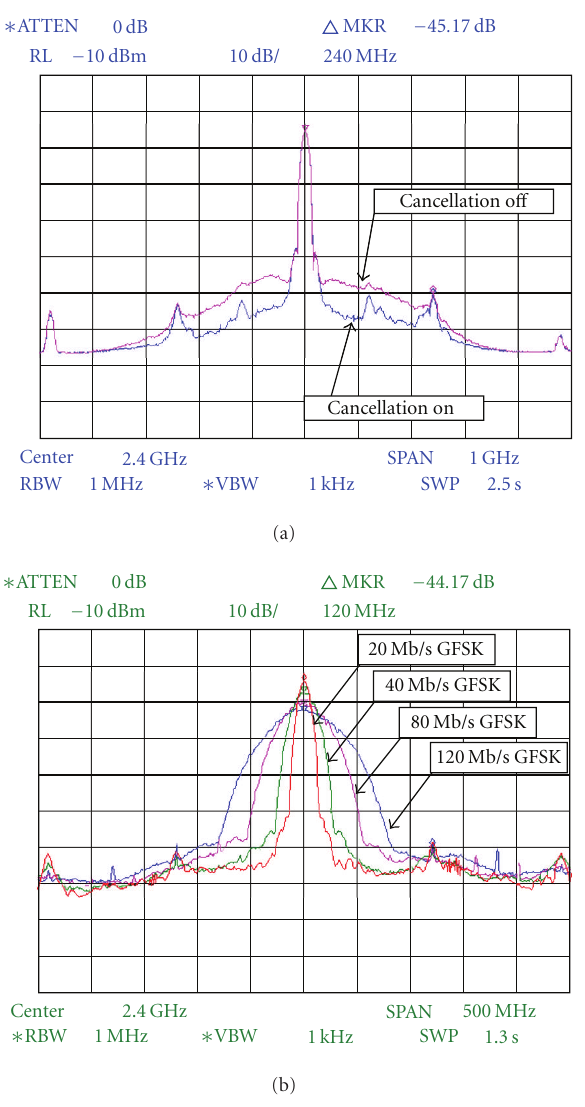
Figure 6: Transmitter output spectrum (a) with noise cancellation ON and OFF; (b) under high speed data transmission [20].